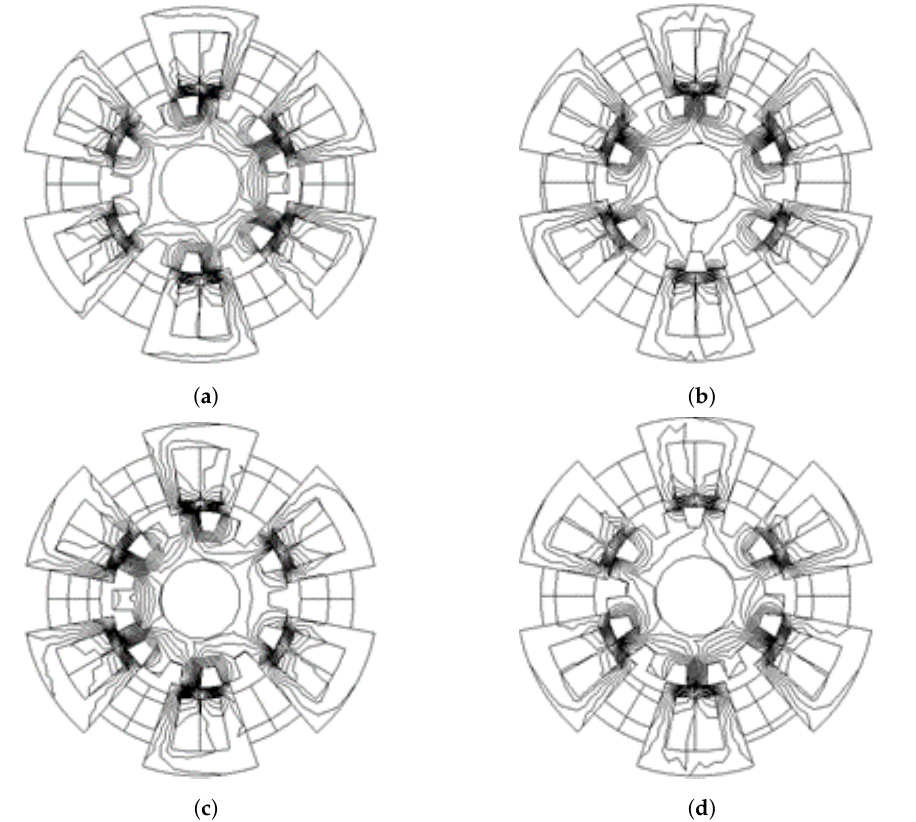
Figure 4. Flux distribution at various electrical degrees. ( a ) 0 ◦ . ( b ) 90 ◦ . ( c ) 180 ◦ . ( d ) 270 ◦ .